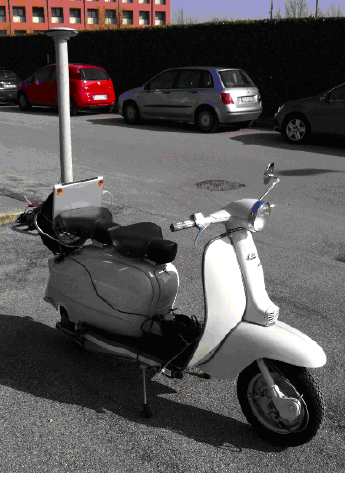
Figure 1. Side view of the Vespa scooter showing the data acquisition sensors. The digital video camera was placed on the right bottom side of the motorcycle.